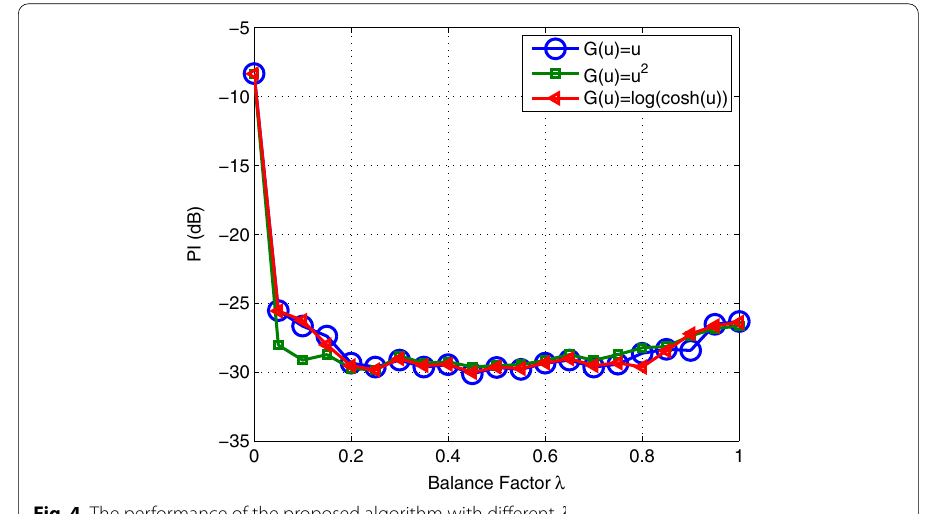
Fig. 4 The performance of the proposed algorithm with different